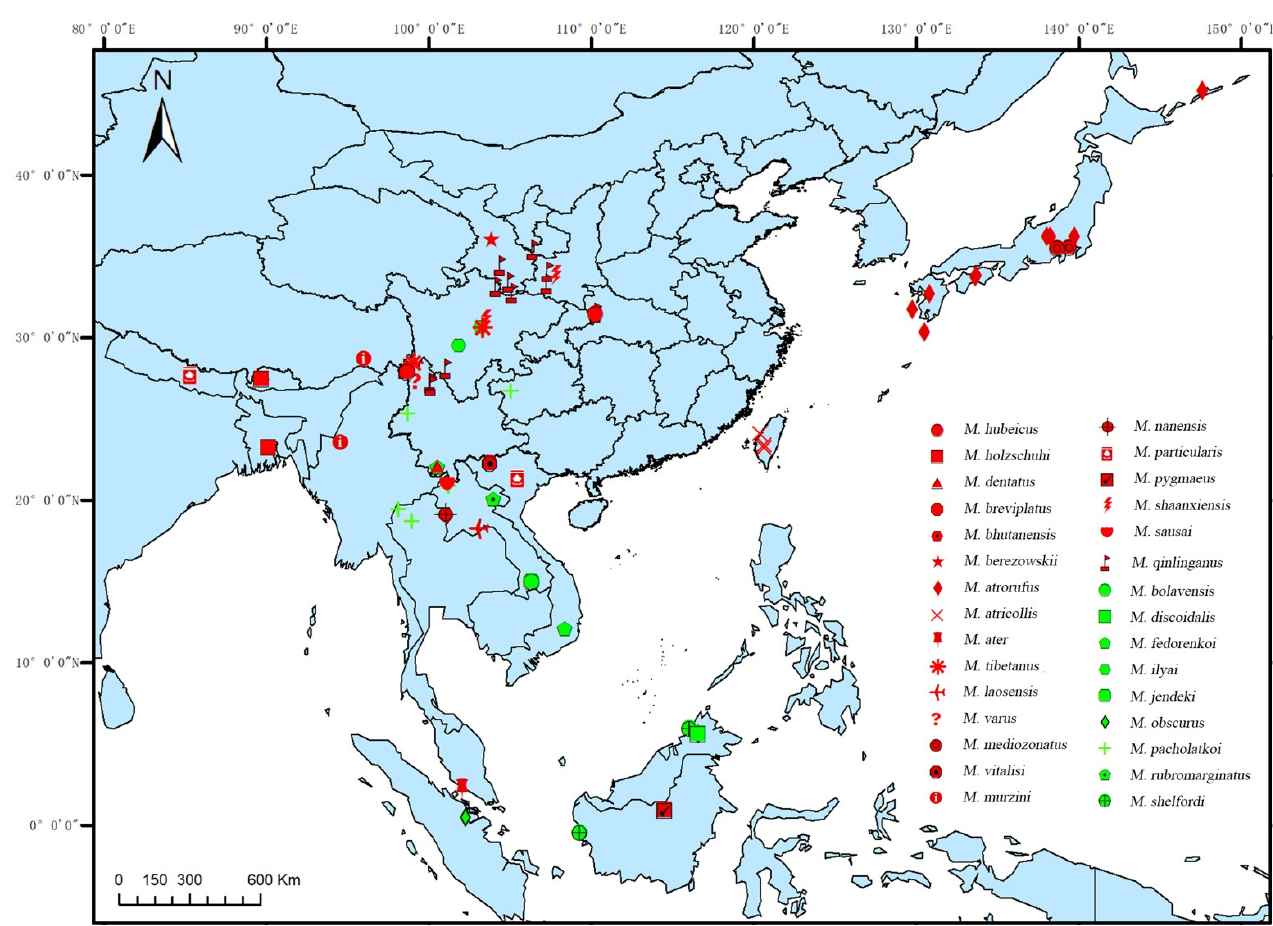
Figure 4. Distribution map of Mesolycus in the world scale (The red represents the atrorufus group and the green denotes the ilyai group).